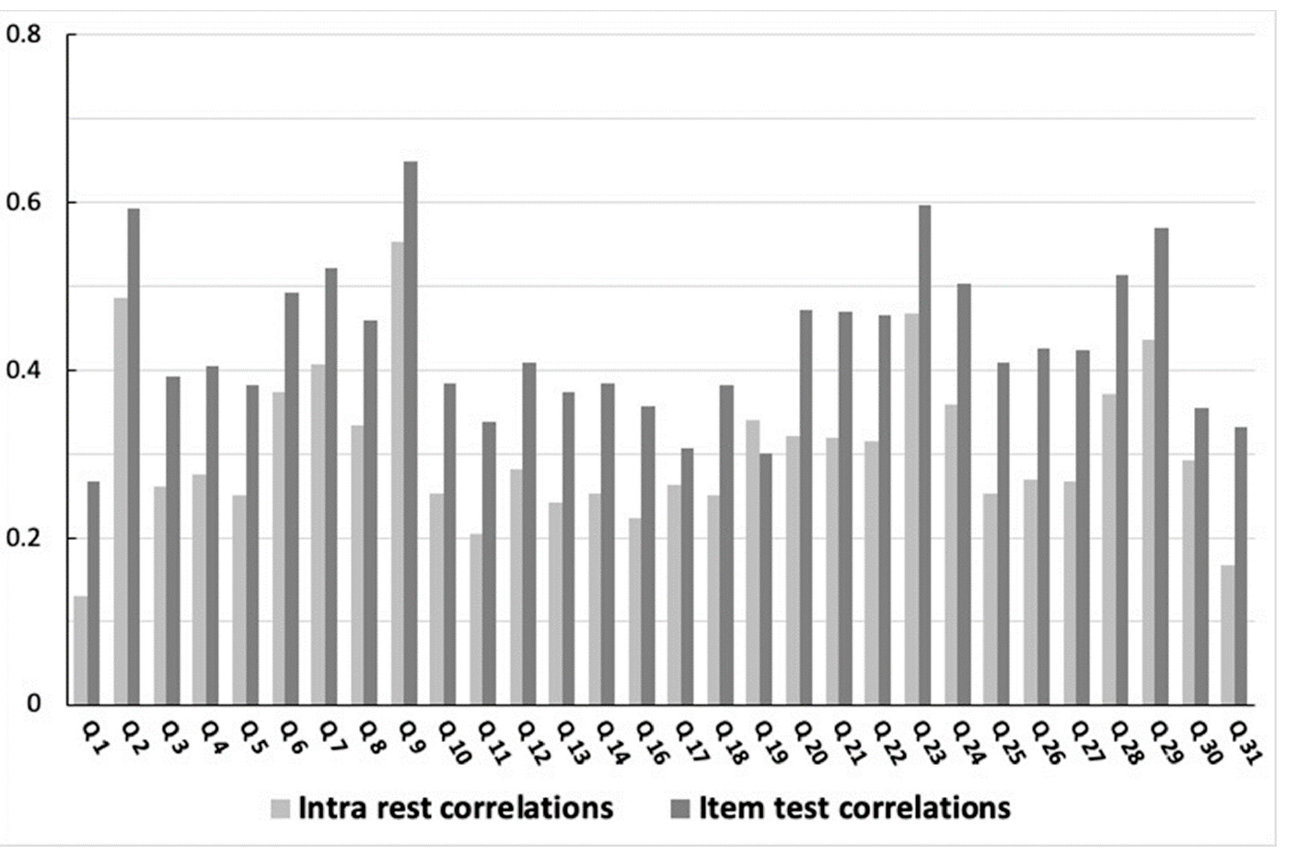
Figure 2. Item rest correlations and item test correlations of every question of the Children and Adolescents Physical Activity and Sedentary-Questionnaire (CAPAS-Q) for the overall sample.